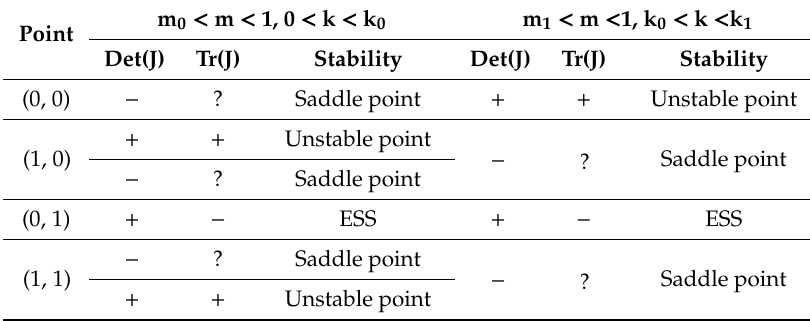
Table 6. Stability analysis of the points in case (3).